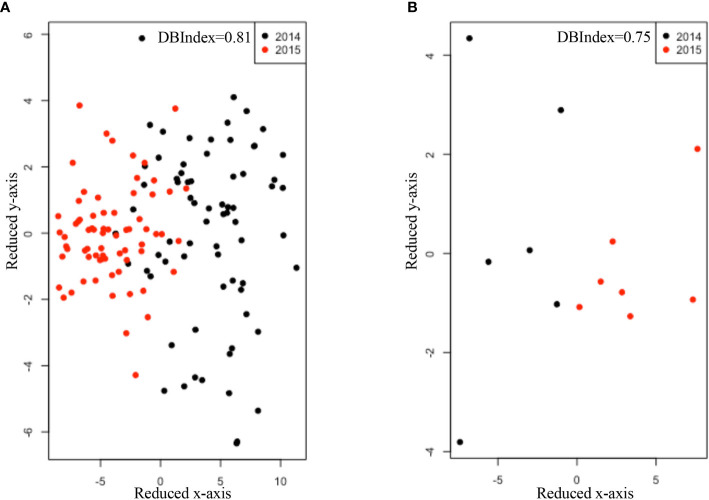
Comparisons of host gene expression patterns using non-parametric method Isomap and DBIndex value for sampling year effect (A) among all samples (B) as well as among Stx2+ samples. Black dots and red dots refer to samples collected in 2014 and 2015, respectively. DBIndex value was shown on the right corner of each figure. The lower DBIndex value, the well-separated cluster pattern.